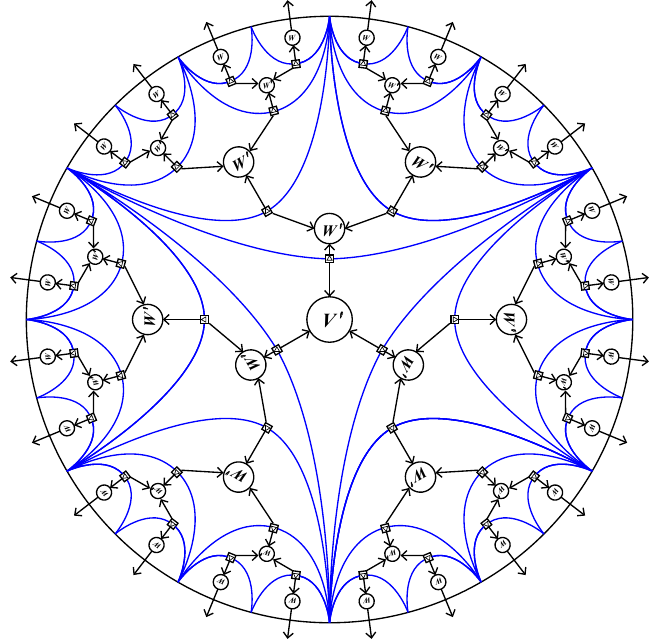
Figure 10 . The resulting tensor network corresponding to our surface growth